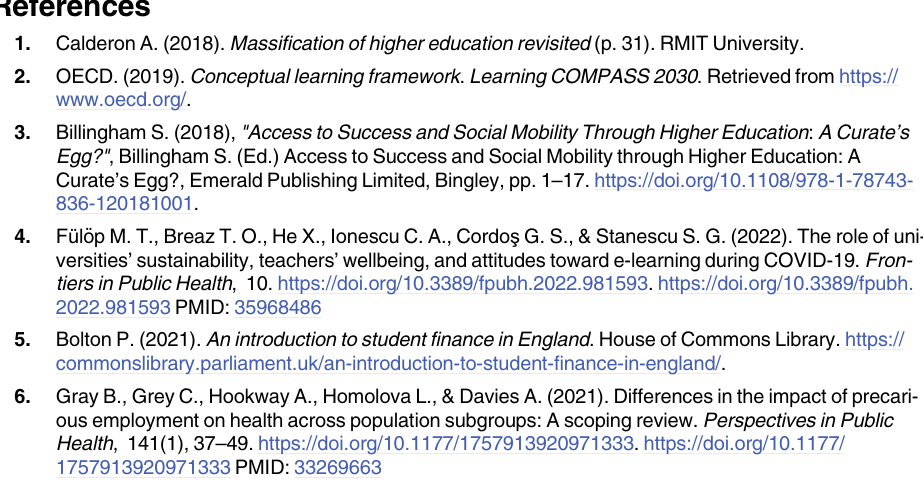
S3 Table. Initial list of codes. S4 Table. Development of codes, subthemes, and